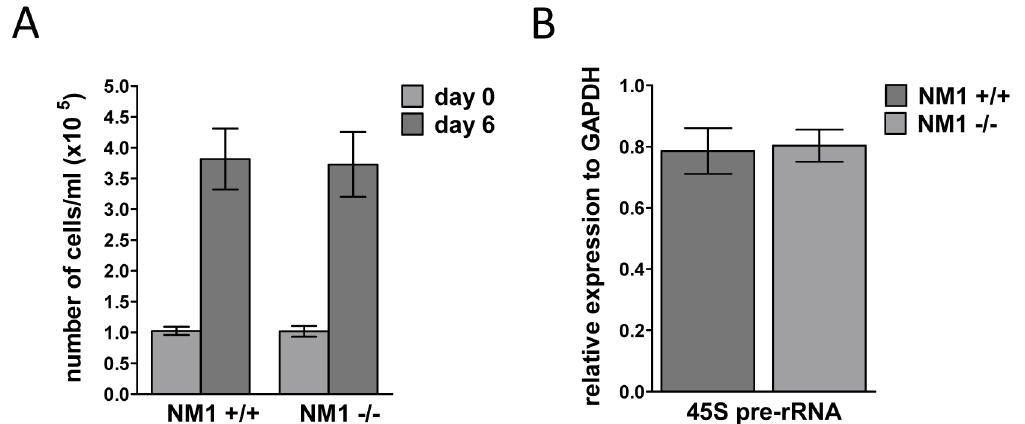
Figure 3. NM1 knock-out has no effect on cell proliferation and Pol I transcription. ( A ) Proliferation of NM1 KO cells (NM1 2 / 2 ) is not altered in comparison to WT cells (NM1 + / + ). 1 6 10 5 cells were seeded on plates (20% confluence; day 0) and let to grow for six days when number of cells was counted again (day 6). ( B ) Pol I transcription rate in NM1 KO (NM1 2 / 2 ) and WT (NM1 + / + ) cells is equal. RNA from exponentially growing cells was isolated and expression of 45S pre-rRNA was measured by RT-qPCR. Expression of 45S pre-rRNA is compared relatively to GAPDH expression. Data are presented as mean + / 2 SD.